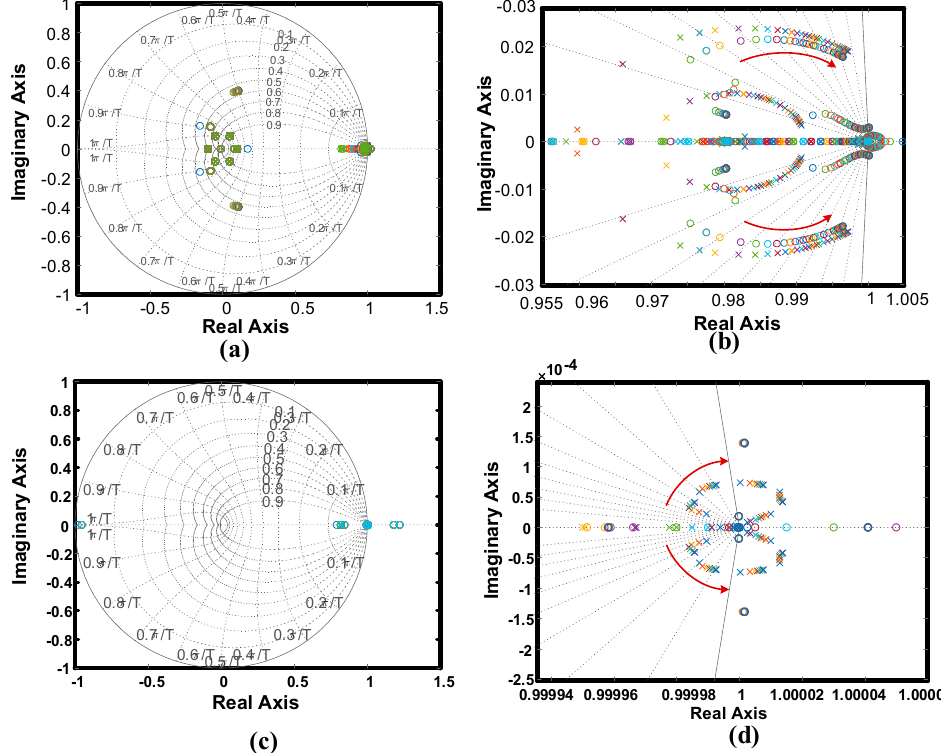
Figure 6. Comparison of the effect of time delays on system stability: ( a ) With proposed distributed Figure.6: Comparison of the effect of time delays on system stability: (a) With proposed distributed averaging method ( b ) With proposed distributed averaging method (magnified) ( c ) With consensus-based averaging method(b) With proposed distributed averaging method (magnified) (c) With consensus-based power estimation method ( d ) With consensus-based power estimation method power estimation method (d) With consensus-based power estimation method (magnified).